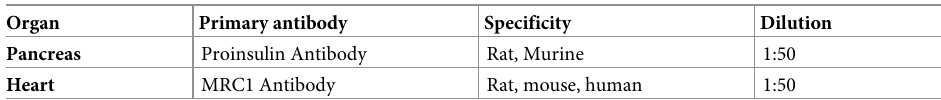
Table 1. Characteristics of immunohistochemistry staining study. Organ Primary antibody Specificity Dilution